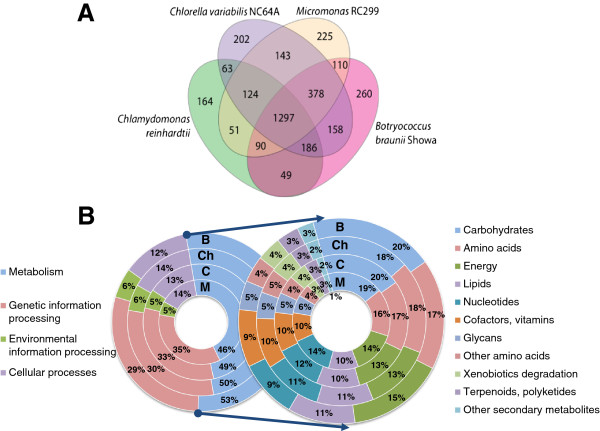
Comparisons of KEGG annotations for Chlorophyta algae. A. Overlap amongst KEGG annotation objects assigned to one or more genes/contigs in the transcriptome of B. braunii Showa, and the genomes of C. reinhardtii, Ch. variabilis NC64A, and Micromonas RC299. Contigs with KEGG annotations found only in the B. braunii Showa transcriptome are listed in Additional file 1: Table S5. B. Distribution of genes/contigs annotated with KEGG ontology categories. Circles on left: first-level ontologies; circles on right: second-level metabolic process ontologies. B, B. braunii Showa; Ch, Ch. variabilis NC64A; C, C. reinhardtii; M, Micromonas RC299.